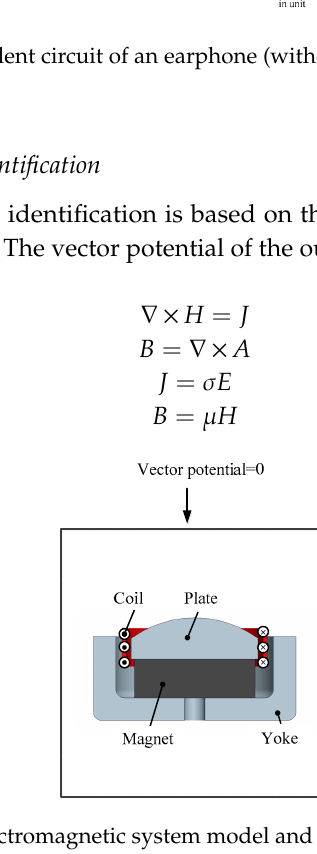
Figure 13. Equivalent circuit of an earphone (without Helmholtz protector).